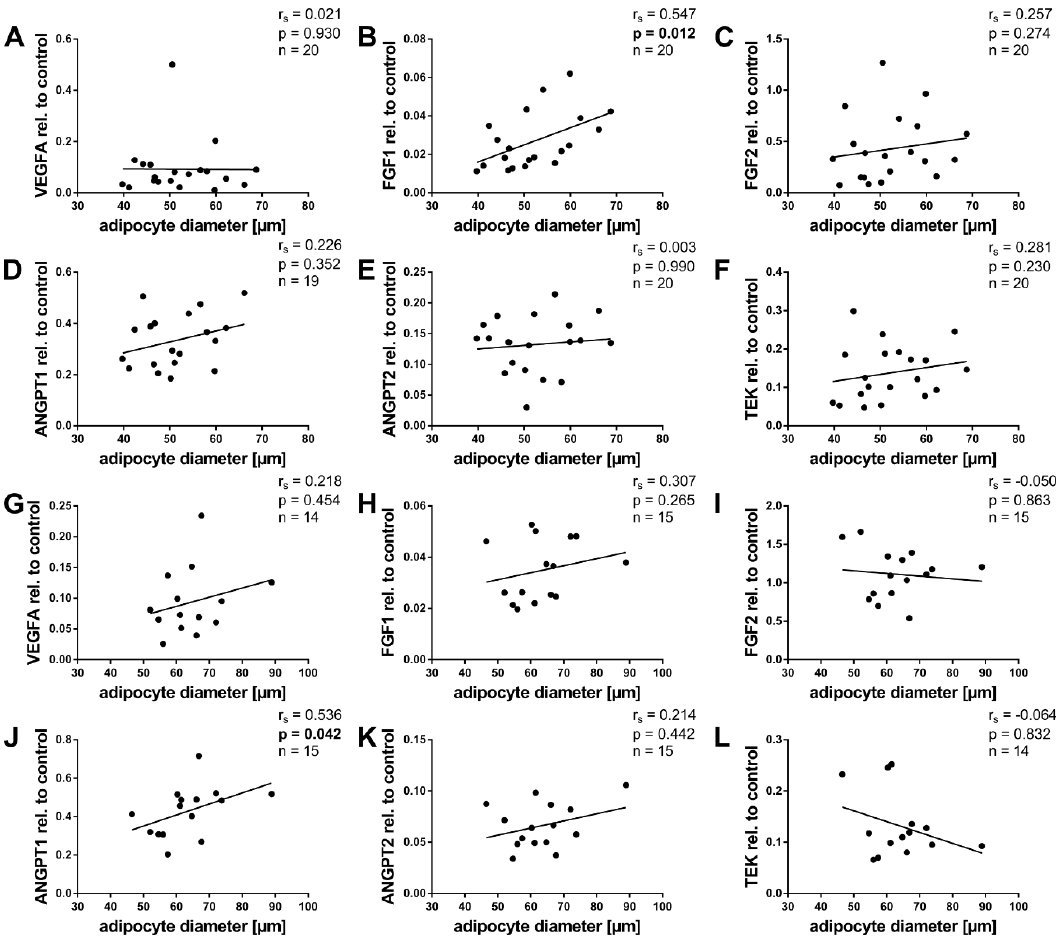
Figure A4. Association of angiogenic gene expression with adipocyte size in the WAT of infants <6 and children ≥6 months. Total RNA was isolated, reverse transcribed, and subjected to qPCR analysis using specific primer pairs as indicated. Respective gene expression was calculated as described in Methods and plotted against adipocyte diameter. ( B ) Only FGF1 correlated positively with adipocyte size in the infants <6 months. ( C, D ) Both FGF2 and ANGPT1, which correlated positively with adipocyte diameter in the analysis with all children, did not correlate significantly with adipocyte size in the infants <6 months. ( A , E , F ) VEGFA, ANGPT2, and TEK showed no significant correlations with adipocyte diameter in the <6 months group. ( G – L ) In contrast, in the children ≥6 months, only ANGPT1 correlated positively with adipocyte diameter (J), while there was no correlation of the other angiogenic factors (G–I, K, L). Spearman correlation coefficient r s and p value, as well as number of subjects, are given in each scatter plot. Significant p values ( p < 0.05) are indicated in bold. Trend lines were calculated as linear regressions.